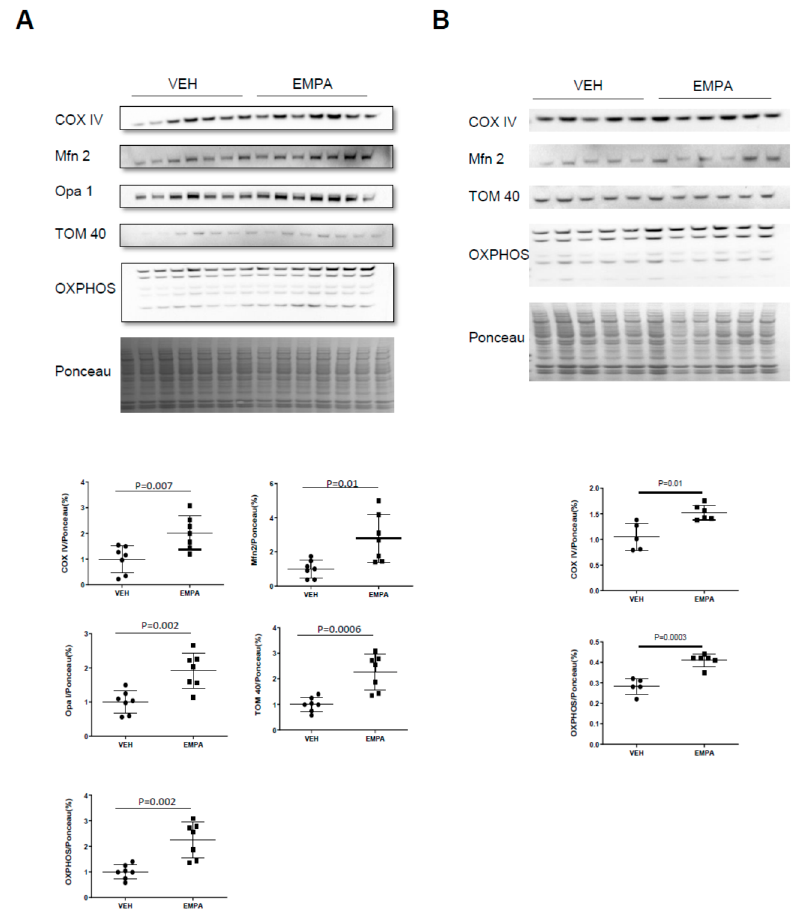
Figure 5. EMPA increases cardiac mitochondrial content in vivo. Mice were subjected to PCAL and then treated with vehicle (0.5% w / v hydroxyethyl cellulose) or EMPA (10 mg/kg/day) for 14 d followed by tissue harvest. ( A ) Cardiac lysates from WT mice were analyzed by Western blot analysis and quantification of mitochondrial markers COX IV, Mfn2, Opa 1, TOM 40 and OXPHOS ( n = 7); ( B ) cardiac lysates from PKO mice were analyzed by Western blot analysis and quantification of mitochondrial markers COX IV, Mfn2, TOM 40 and OXPHOS ( n ≥ 5).